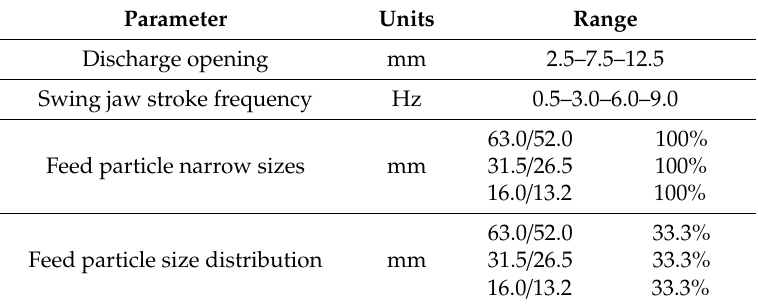
Table 5. Operating conditions adopted in the DEM simulations of the jaw crusher